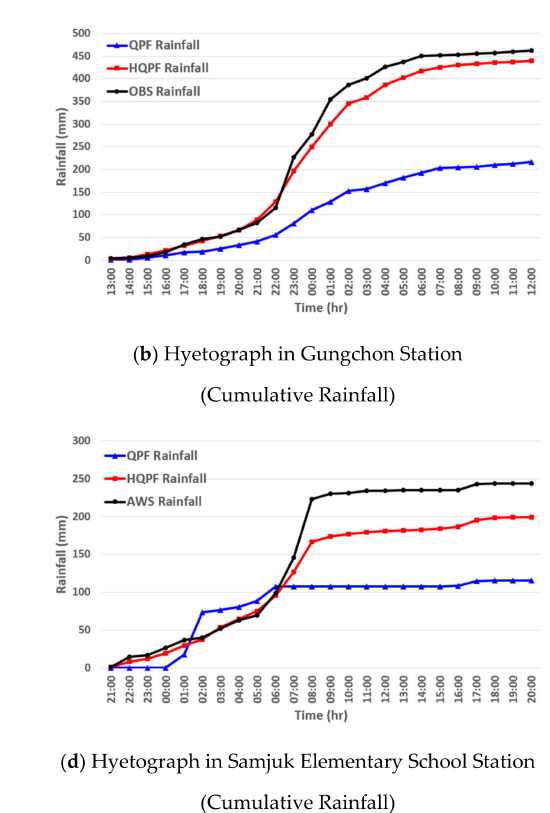
Figure 7. Location of the Station. ( A ) Gungchon station, ( B ) Samjuk Elementary School station, and ( C ) Ogwa Tollgate station.